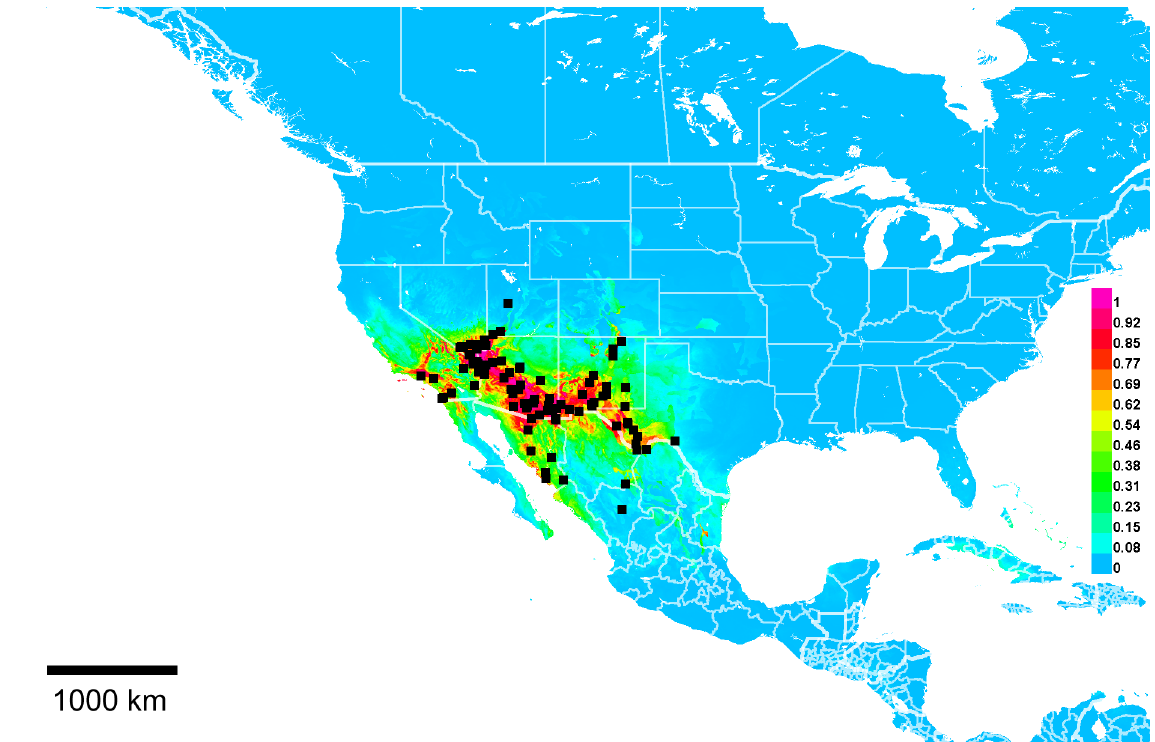
Fig. 14. Georeferenced collection records of Lasioglossum ( D .) deludens sp. nov. (black squares) and predicted distribution by maximum entropy ecological niche modelling in Maxent (colour shading). Warmer colours indicate higher cloglog probability of